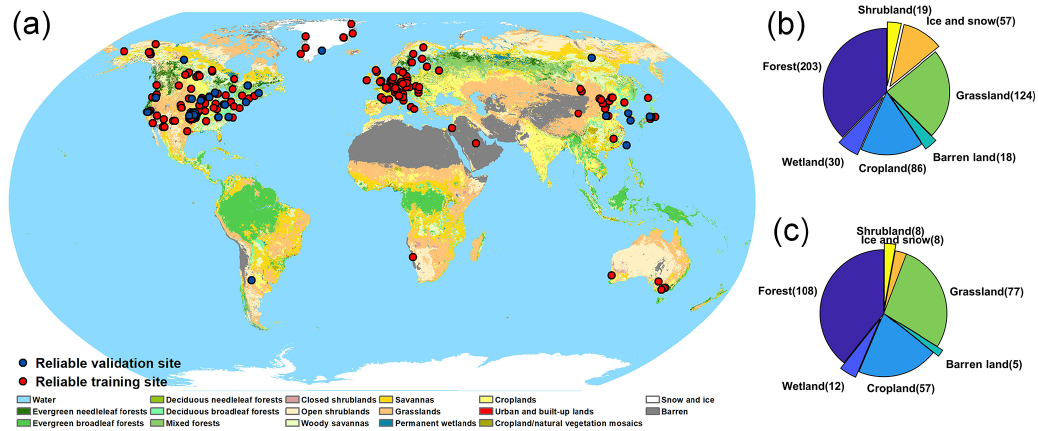
Figure 4. (a) Spatial distribution of reliable sites and the absolute numbers of (b) all sites and (c) reliable sites under different surface types. Table 6. Ten-fold cross-validation performance of the RCNN models. Used